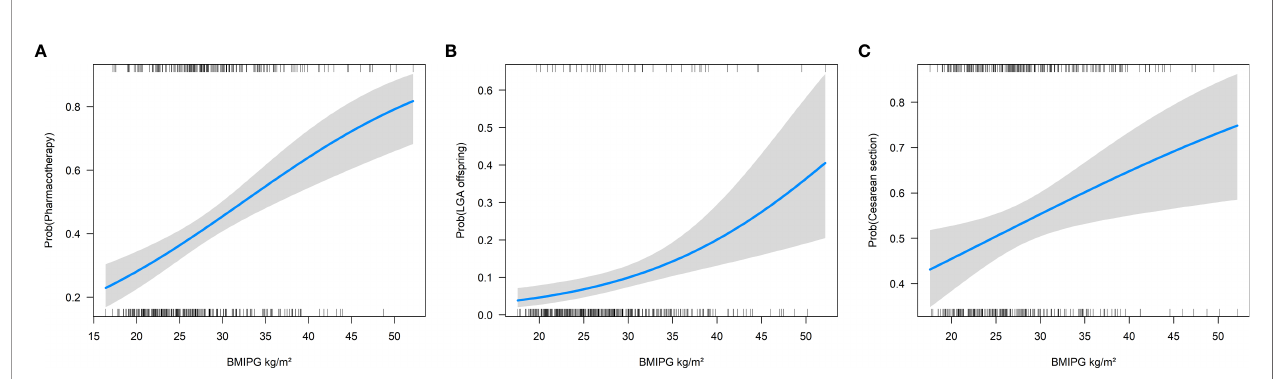
FIGURE 1 | Association of pregestational BMI (BMIPG) with the probability of receiving pharmacotherapy (A) , for delivering large for gestational age (LGA) offspring (B) and having delivery by cesarean section (C)